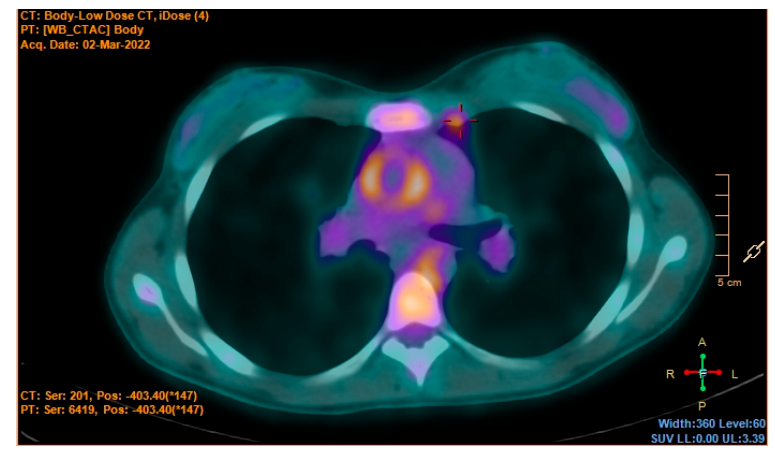
Figure 2. PET-TC. Increased metabolic activity of the ascendent aorta.